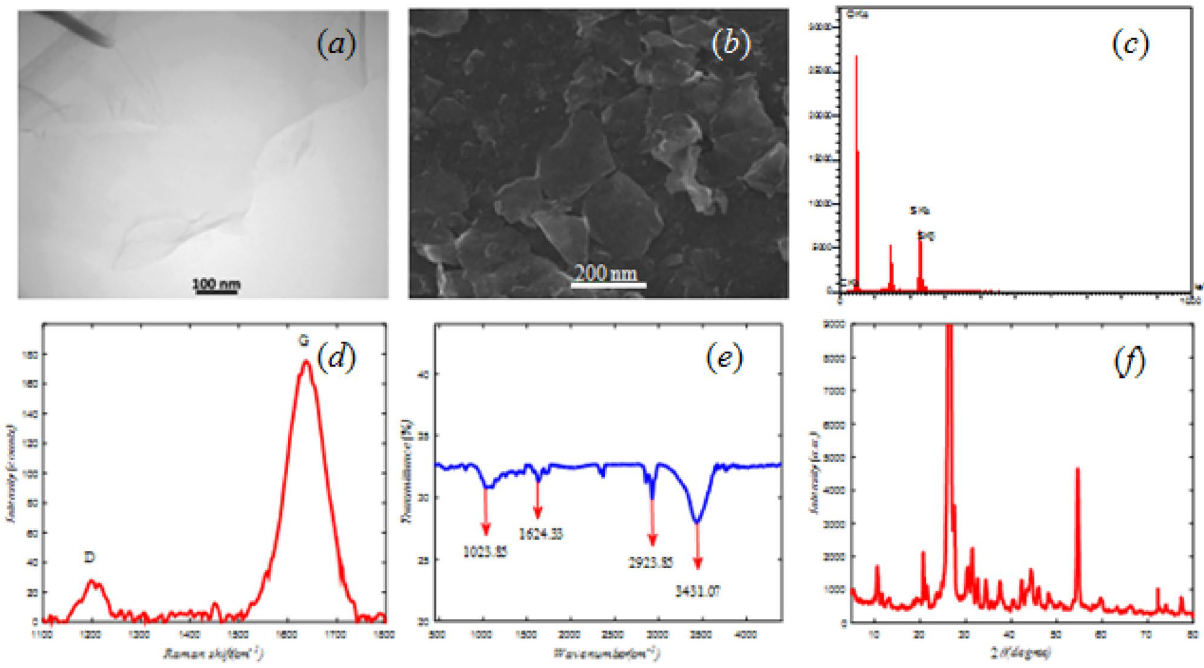
Figure 1. (a) TEM, (b) SEM, (c) EDX, (d) Raman, (e) FTIR, and (f) XRD analysis of